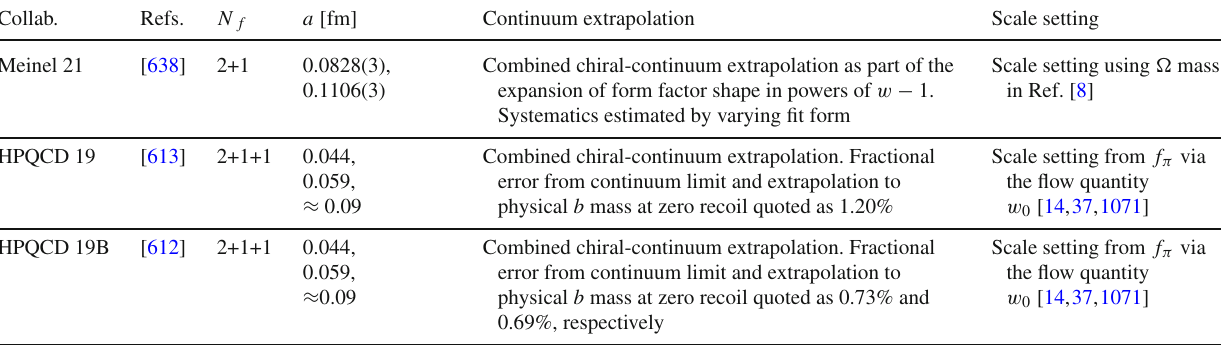
(cid:6)ν and (cid:8) → (cid:8) ( ∗ ) (cid:6) ¯ ν form b c s )